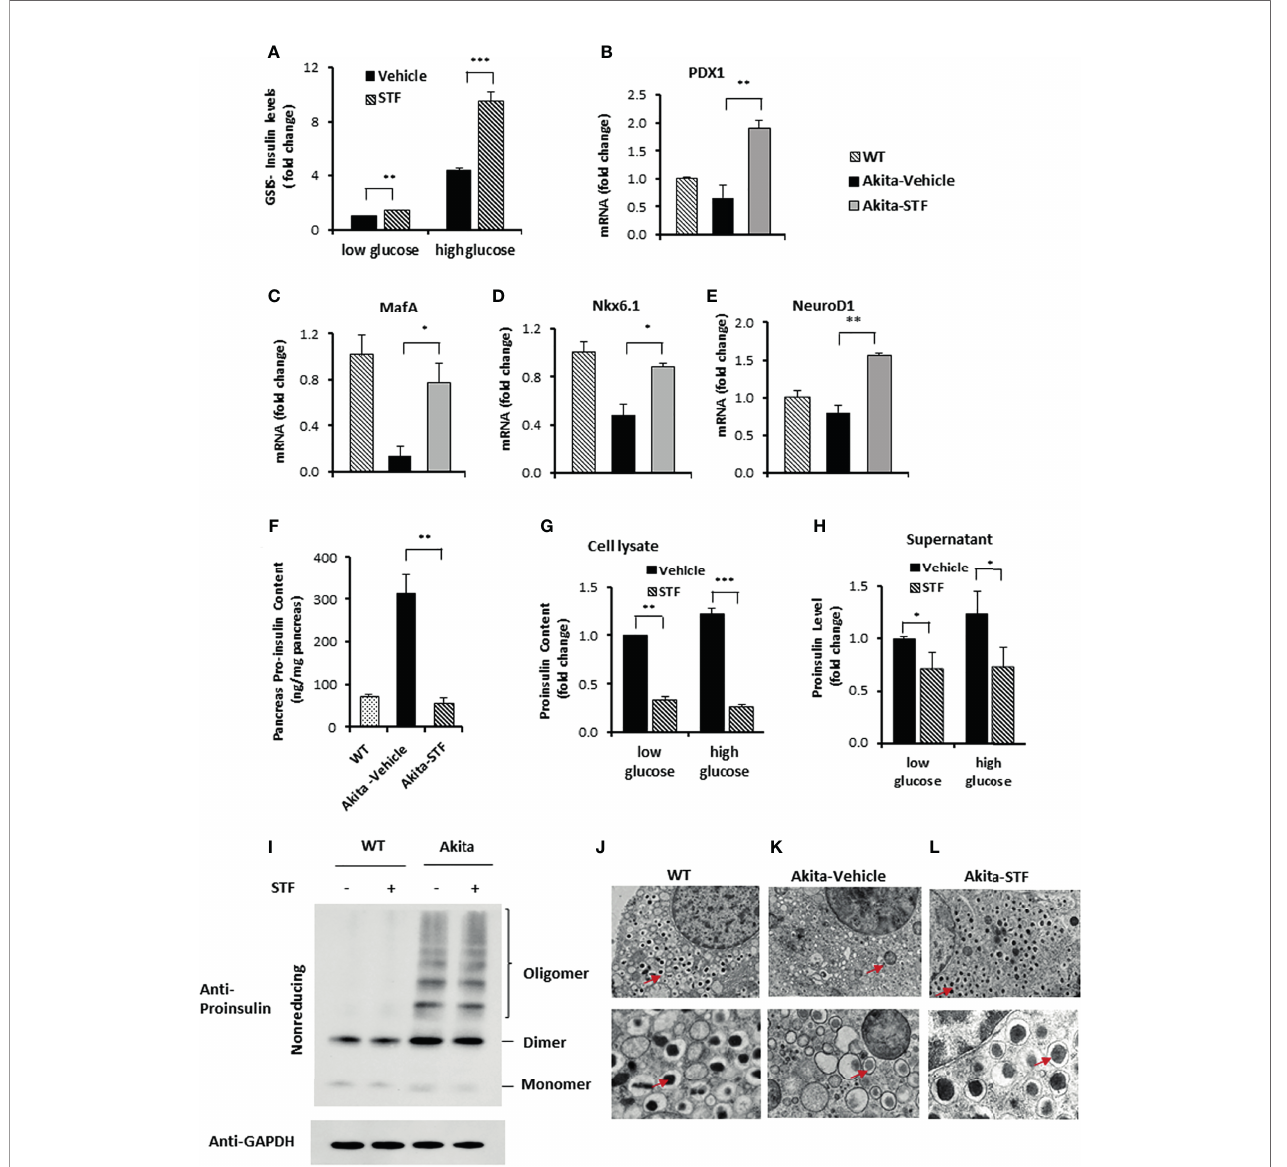
FIGURE 5 | STF improves Akita islet b -cell function. (A) Glucose-stimulated insulin secretion of 20 islets isolated from Akita mice treated with STF or vehicle and incubated with 2.5 mM and 16.7 mM glucose. Secreted insulin was measured by ELISA. The data was presented as fold change and normalized with total protein concentration, with the amount of insulin secreted in response to 2.5 mM glucose from vehicle-treated group set to 1.0. (B – E) mRNA levels for indicated genes were analyzed in islets isolated from Akita mice treated with STF or vehicle by qRT-PCR. The results are expressed as fold change and are representative of 3 independent experiments. (F) Proinsulin content measurement by ELISA as detailed in Methods and Materials. (G, H) Proinsulin content and secretion measurement. 20 islets isolated from Akita mice treated with STF or vehicle were incubated with 2.5 mM and 16.7 mM glucose. Secreted proinsulin was measured by ELISA. Proinsulin content measurement by ELISA as detailed in Methods and Materials. The data was presented as fold change and normalized with total protein concentration, with the amount of proinsulin in response to 2.5 mM glucose from vehicle-treated group set to 1.0. (I) Proinsulin misfolding detection by Western blotting under nonreducing condition. Islets were treated with compounds at indicated concentrations for 16 hours. The data is representative of 3 independent experiments. (J – L) Ultrastructure of b -cells in islets isolated from Akita treated with STF as in by transmission electron microscopy. Images at the top panel and the bottom panel were taken at 3,000x and 10,000x, respectively. Arrows point to dark mature insulin granules. *P < 0.05, **P < 0.01, and ***P <